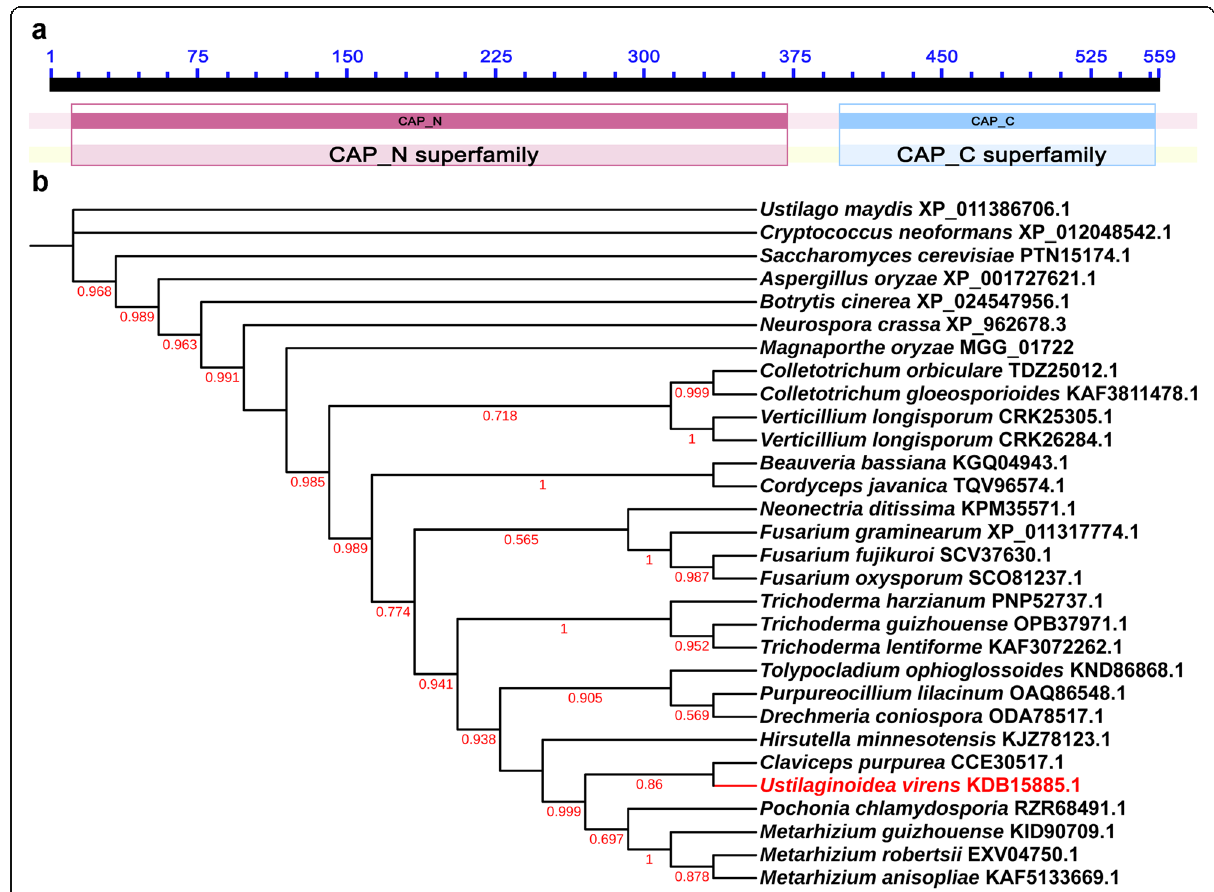
Fig. 1 Phylogenetic analysis of CAP homologous proteins. a The domain structure of UvCap1 in U. virens . b Phylogenetic tree of fungal CAP homologous proteins. All the sequences of CAP homologous proteins were downloaded from NCBI and their accession numbers are shown after the fungus names. The numbers indicate bootstrap